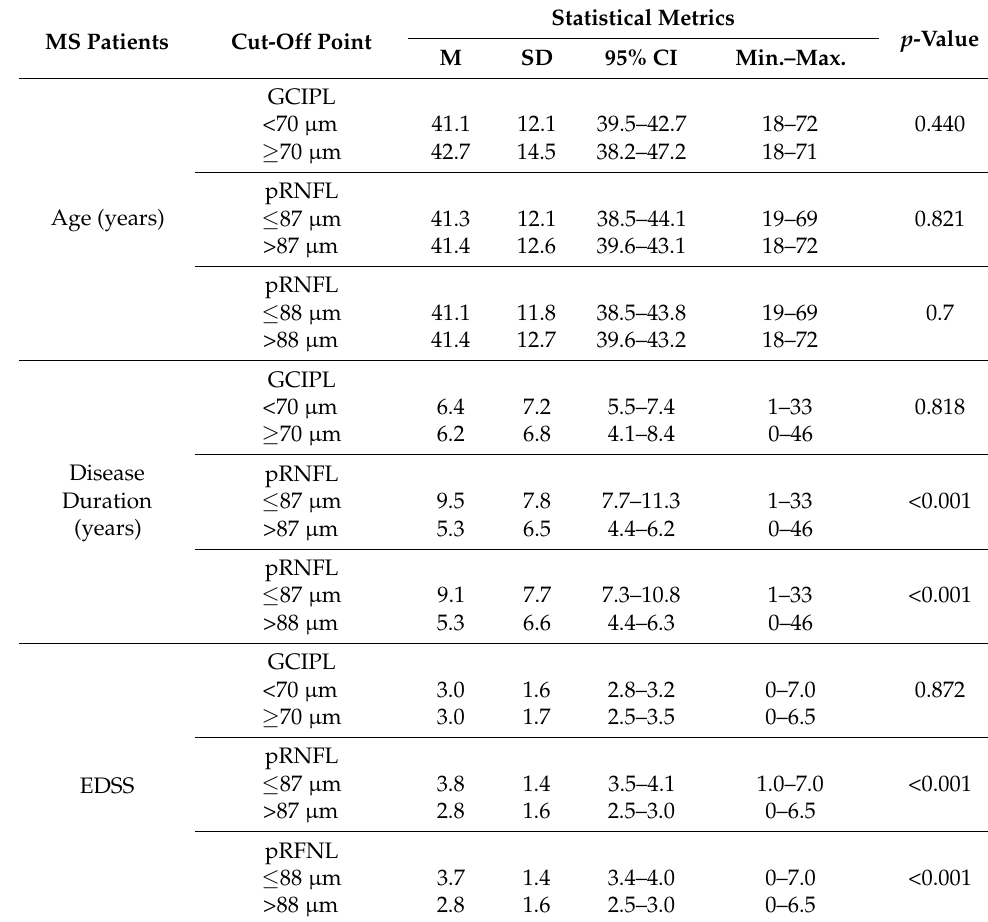
Table 3. Characteristics of the study cohort by GCIPL and pRNFL cut-off values (numerical variables) (n =